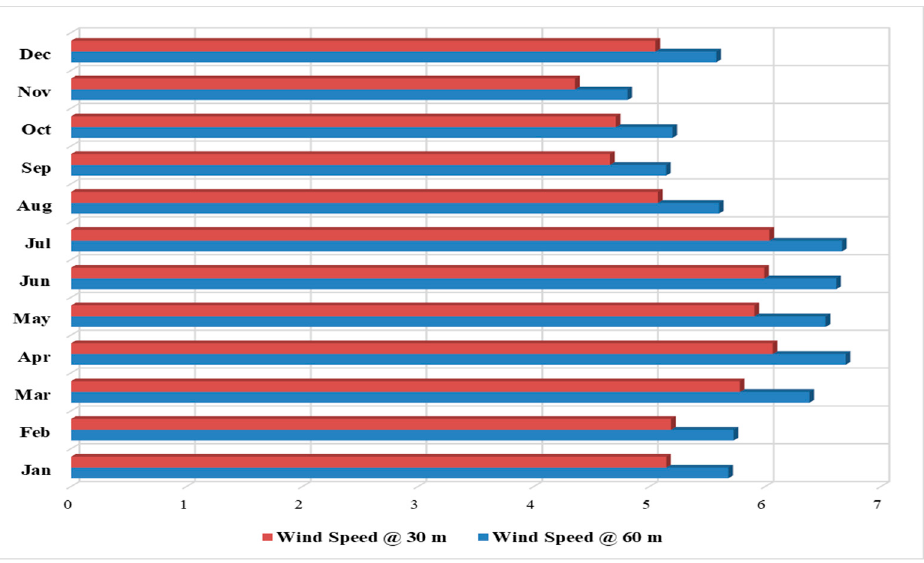
Figure 3. Monthly mean wind speeds at heights of 30 m and 60 m for 12 months of the year.